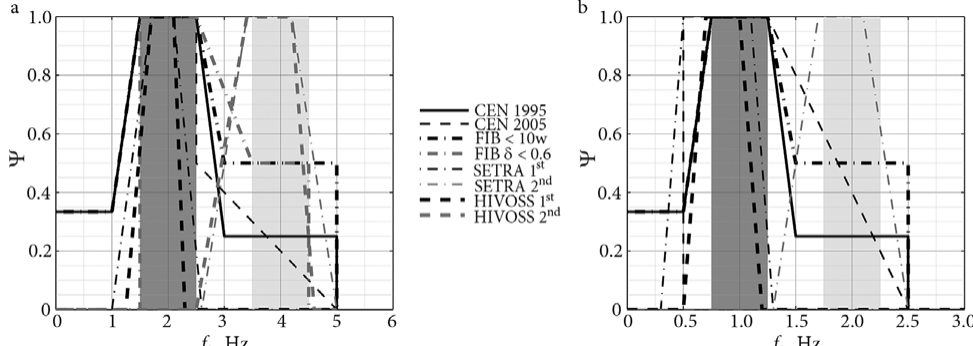
Fig. 4. Comparison of the Ψ ( f i ) coefficients suggested by different Standards and Guidelines for (a) vertical and (b) lateral components; the grey and light grey areas indicate the frequency range for the first and second harmonics of GRFs (Ricciardelli, Demartino